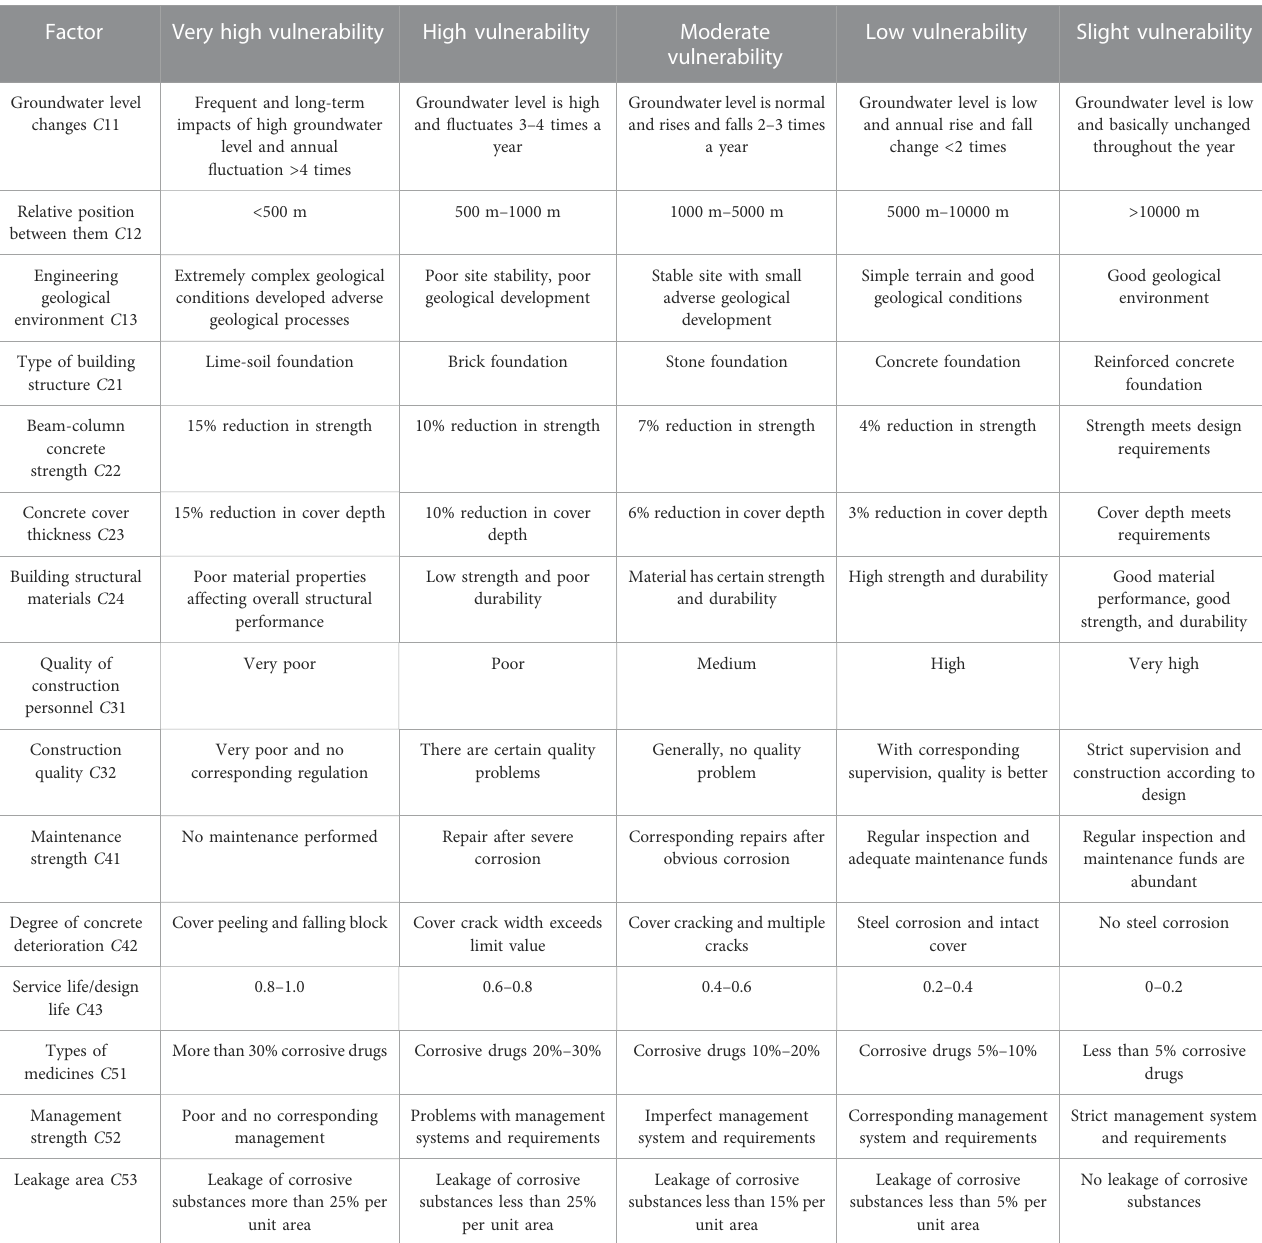
TABLE 3 Probability characteristics of modeling uncertainty parameters (Wei et al., 2008; Li, 2012; DB11 ∕ 637-2015 and Standard for structure comprehensive, 2015; Zhang and Xu, 2021; Zhang et al., 2020).